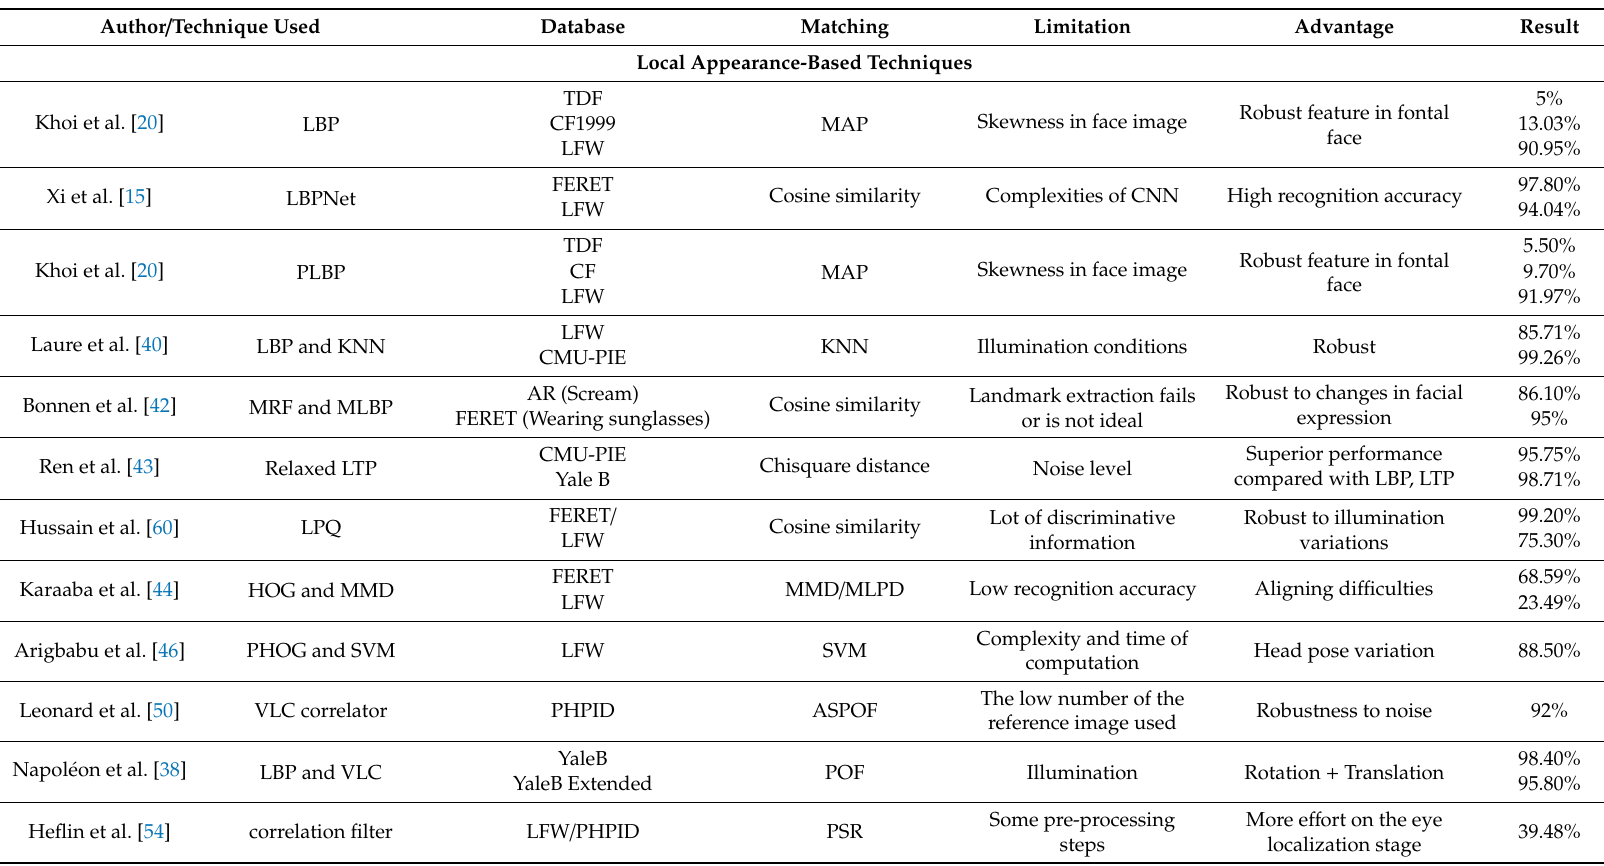
Table 1. Summary of local approaches. SIFT, scale-invariant feature transform; SURF, scale-invariant feature transform; BRIEF, binary robust independent elementary features; LBP, local binary pattern; HOG, histogram of oriented gradients; LPQ, local phase quantization; PCA, principal component analysis; LDA, linear discriminant analysis; KPCA, kernel PCA; CNN, convolutional neural network; SVM, support vector machine; PLBP, pyramid of LBP; KNN, k-nearest neighbor; MLBP, multiscale LBP; LTP, local ternary pattern.; PHOG, pyramid HOG; VLC, VanderLugt correlator; LFW, Labeled Faces in the Wild; FERET, Face Recognition Technology;